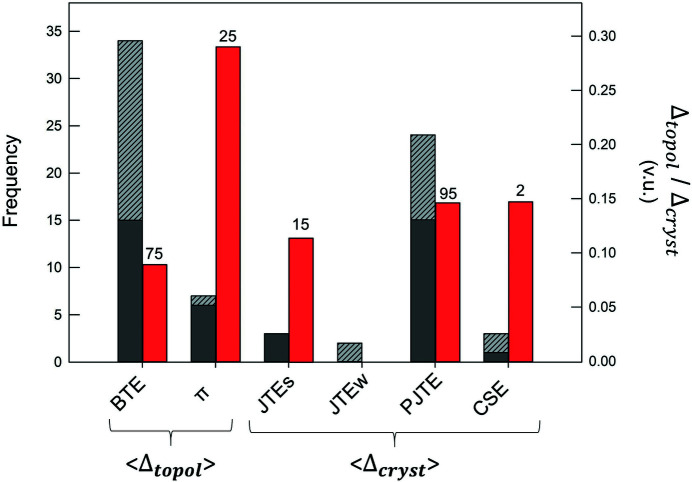
Frequency for which bond-topological effects (BTE), multiple-bond formation (π), the strong (JTEs) and weak (JTEw) Jahn–Teller effects, the pseudo Jahn–Teller effect (PJTE) and crystal-structure effects (CSE) are the main (dark grey) and minor (light grey) causes of bond-length variation underlying the ion configurations of Table 4 ▸. These data are necessarily biased toward anomalous bond-length distributions, whereas the BTE is ubiquitous across all ion configurations. Mean Δtopol and Δcryst values (right-hand axis) are calculated using those polyhedra for which the given effect is the main cause of bond-length variation. The numbers atop each bar represent the sample size.